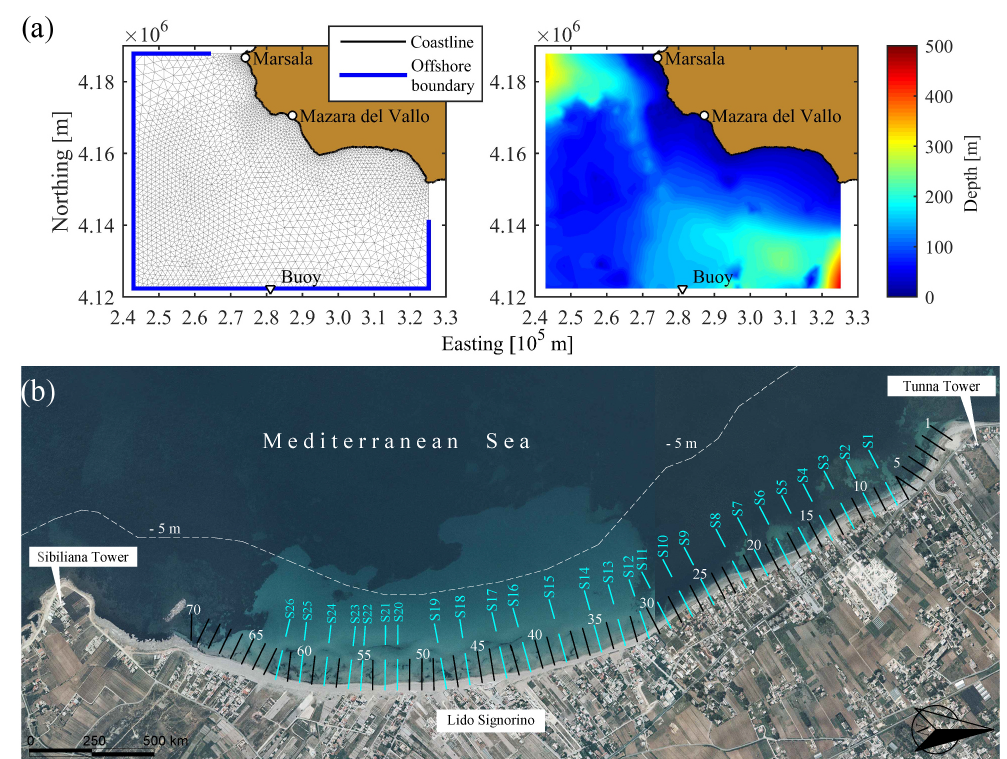
Figure 4. (a) The unstructured mesh of the numerical domain (Monteforte et al., 2015). The blue bold line in the left panel represents the domain boundary along which the offshore wave conditions were imposed; the right panel represents the bathymetry of the studied area). (b) Location of the 26 sections chosen for the run-up analysis; each section is identified by a number preceded by S that distinguishes them from the transects, identified by a number only.